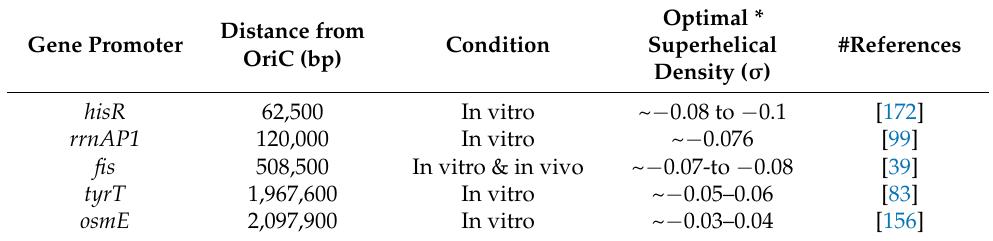
Table 1. Optimal superhelical density for promoter activity as a function of distance from OriC (OriC at 3.92 Mbp; Ter at 1.59 Mbp).